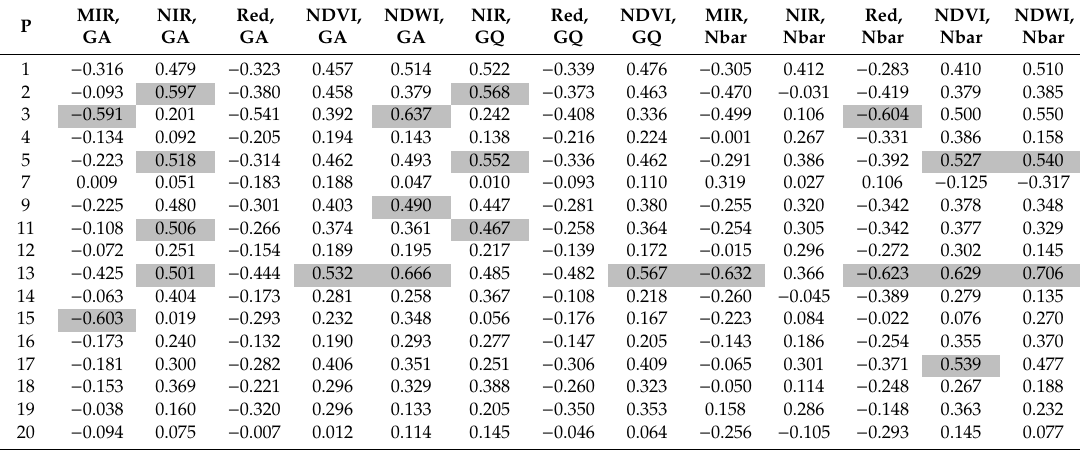
Table 5. Pearson correlation coe ffi cients between delta median height (di ff erence between one date and the previous one) and delta daily MODIS satellite variables for every analyzed paddock